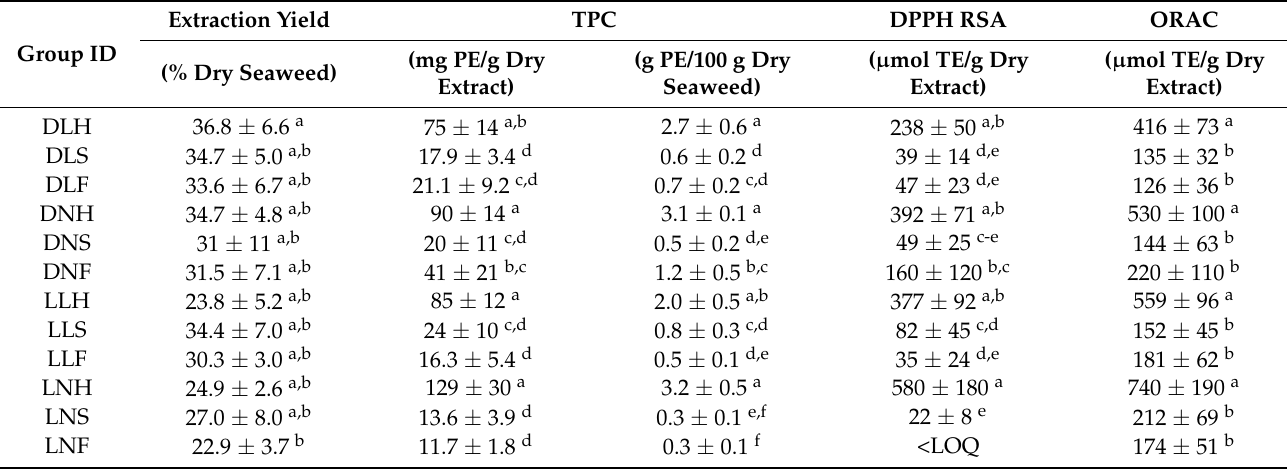
Table 3. Total polyphenol content, DPPH radical scavenging activity, and ORAC values of the twelve sample groups expressed on a dry extract basis. Extraction yield (% w/w , g extracted solids/100 g dry seaweed) and TPC denoted as g PE/100 g dry seaweed are also